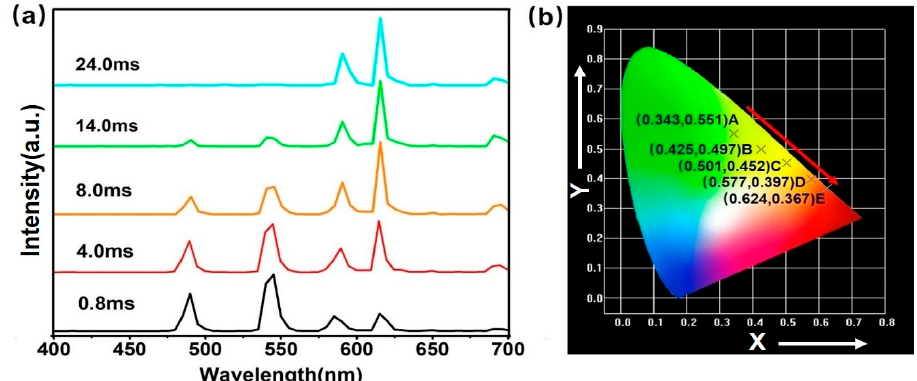
Figure 6. ( a ) Time-resolved emission spectra for NaYF 4 :Yb/Er@NaYF 4 :Ce/Tb 0.1 /Eu 0.05 microrods at 252 nm excitation. ( b ) The CIE coordinates of the sample at various delay times.